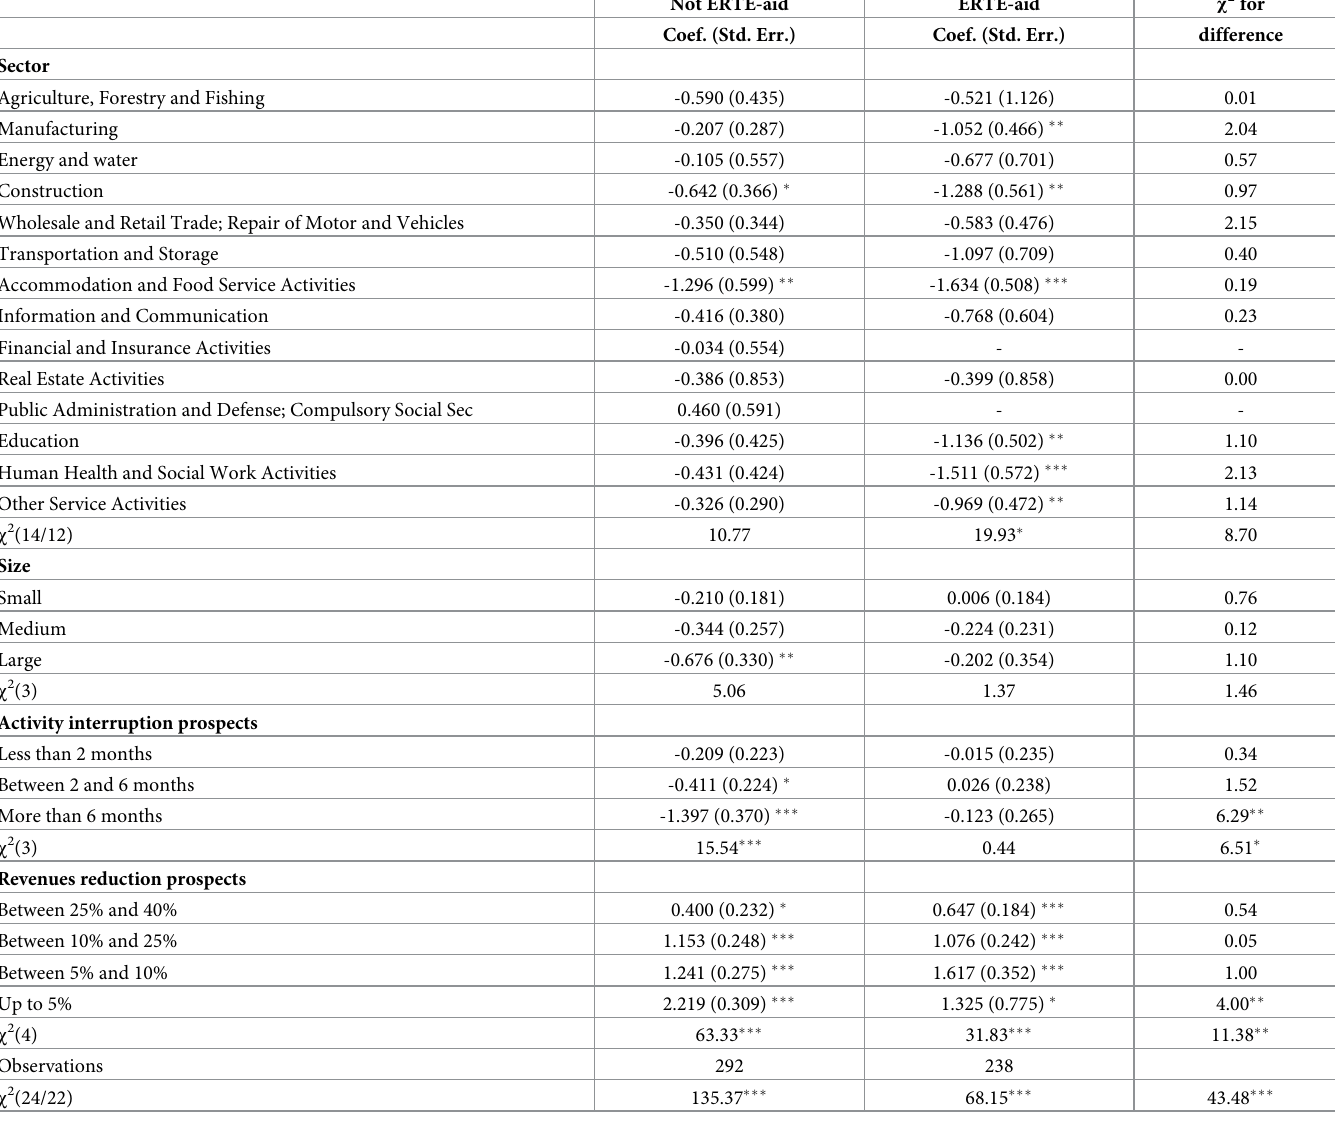
Table 5. Ordered probit estimation of anticipated employment reduction for firms with ERTE-aid and for firms without ERTE aid. Not ERTE-aid ERTE-aid χ 2 for Coef. (Std. Err.) Coef. (Std.